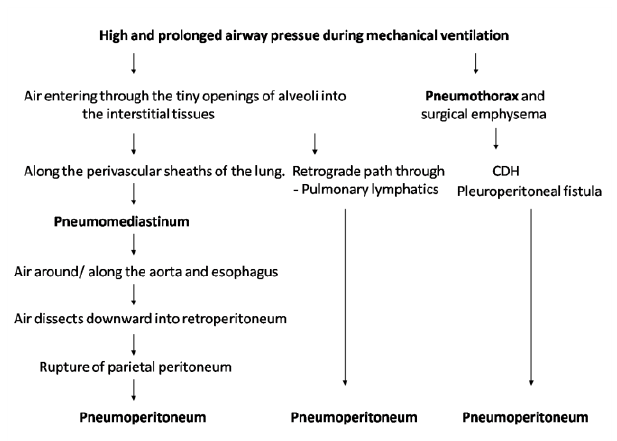
Figure 3: A flow chart to explain the mechanism in the de- velopment of spontaneous